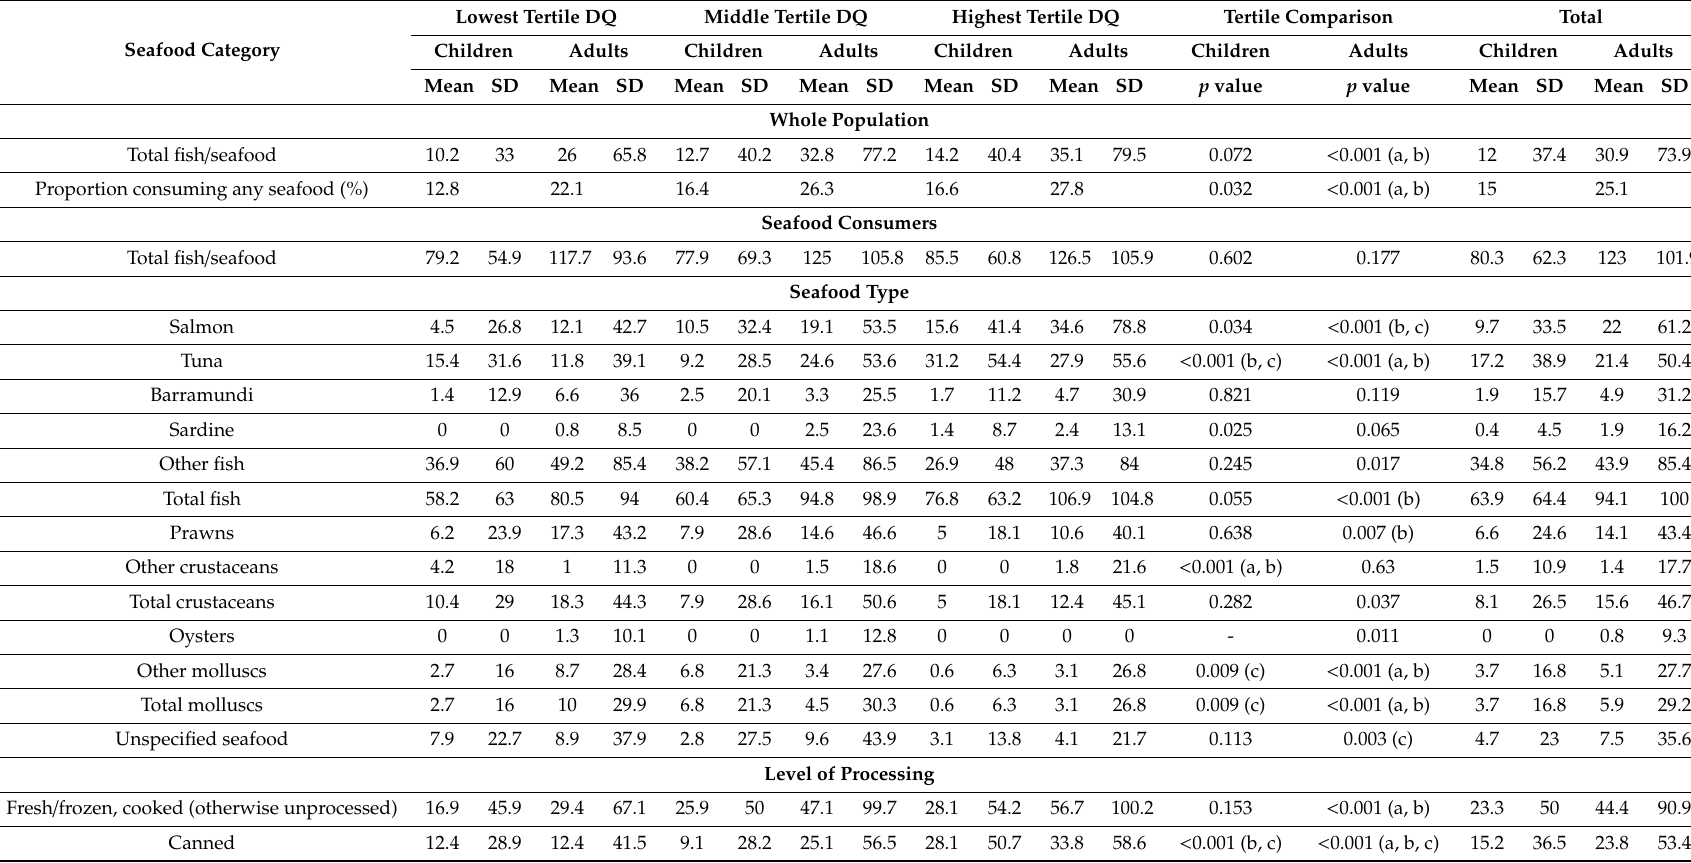
Table A1. Mean quantity of di ff erent categories of fish and seafood consumed by adults and children according to diet quality tertiles (g / person /